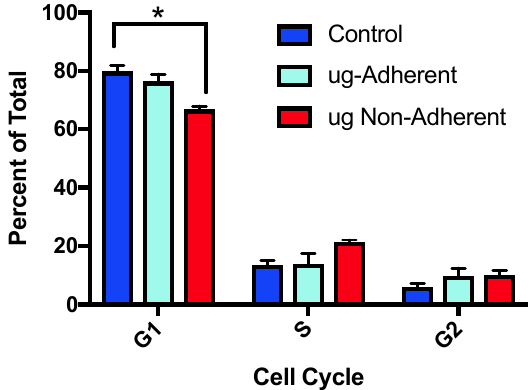
Figure 1. Binned cell diameters of control and simulated microgravity treated cells. The cell diameters of two populations of simulated microgravity cells (adherent and non-adherent) were defined, binned based on size and compared with controls (average % diameter +/ − SE), * p < 0.004.